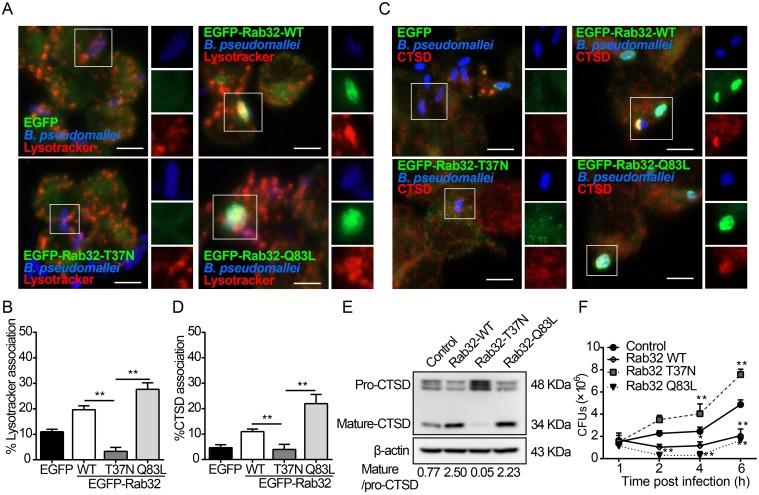
Rab32 increases fusion of B. pseudomallei-containing phagosomes with lysosomes.(A) RAW264.7 cells expressing the different constructs were incubated with 50 nM Lysotracker for 1 h before infection with B. pseudomallei, and stained for B. pseudomallei (blue). Scale bar is 5 μm. (B) Quantitative analysis of B. pseudomallei phagosomes associated with Lysotracker. Results are represented as mean ± S.D. of three independent experiments. (C) RAW264.7 cells transfected with the indicated constructs were infected with B. pseudomallei, and cells were fixed and stained for cathepsin D (CTSD, red) and B. pseudomallei (blue). Scale bar is 5 μm. (D) Analysis of the number of B. pseudomallei phagosomes positive for CTSD. Results are represented as mean ± S.D. of three independent experiments. (E) Rab32 and its mutants were overexpressed in RAW264.7 cells and cells were infected with B. pseudomallei (MOI = 10) for 2 h, total cellular extracts were prepared and subjected to western blotting using antibody against CTSD. (F) RAW264.7 cells selected for the expression of EGFP, EGFP-Rab32, EGFP-Rab32-T37N, and EGFP-Rab32-Q83L were infected with B. pseudomallei at the indicated time points, cells were lysed, and CFU determined. Results are represented as mean ± SD for at least three separate experiments (*P<0.05, **P<0.01).